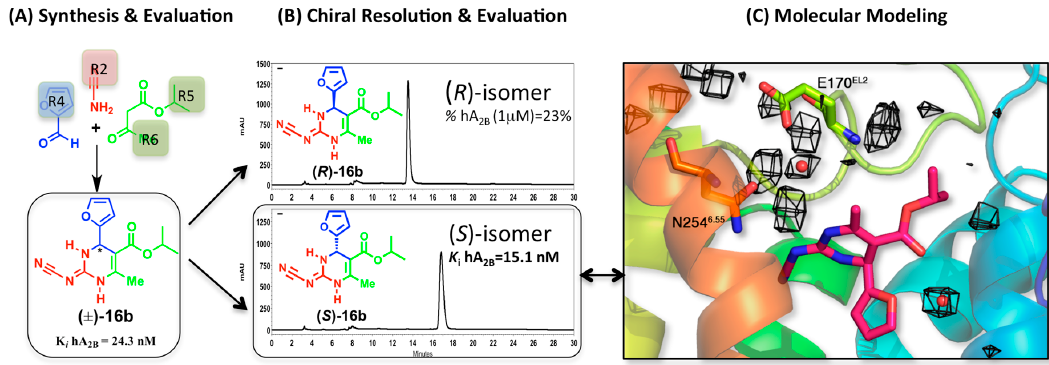
Figure 4. Synthesis and enantiospecific binding characterization of compound 16b as antagonist of the A 2B AR: ( A ) the Biginelli multicomponent reaction allows the assembly of the 3,4-dihydropyrimidine scaffold bearing different diversity points; ( B ) the chiral resolution identified the S isomer as the one responsible of the biological affinity of the racemic mixture; and ( C ) the molecular modeling confirmed the binding mode previously hypothesized for isomer ( S) - 16b . The water-density maps (black mesh) are calculated here by means of MD exploration (grid spacing 1 Å, occupancy > 80%), and are overlaid with the position of structural waters previously considered during the docking of this series (red spheres).